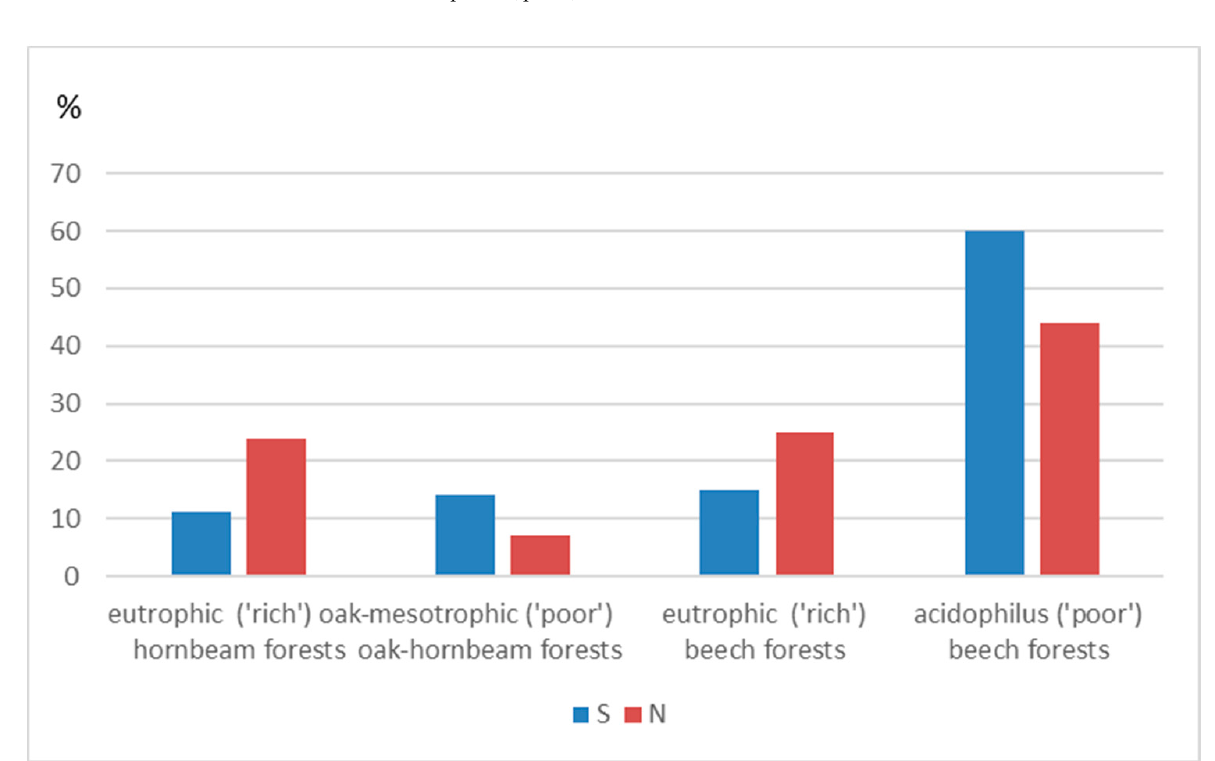
Acidophilus (‘poor’) beech forests Individual groups of communities include data on the following communities listed in Table 1 and marked with numbers: eutrophic (‘rich’) oak-hornbeam forests—communities Nos. 11, 13; mesotrophic (‘poor’) oak-hornbeam forests—communities Nos. 10, 12; eutrophic (‘rich’)